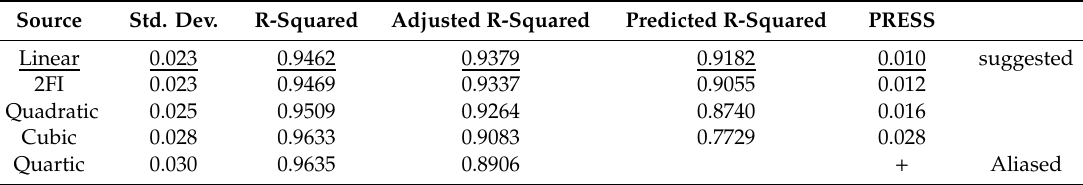
Table 12. Model summary statistics for microhardness.